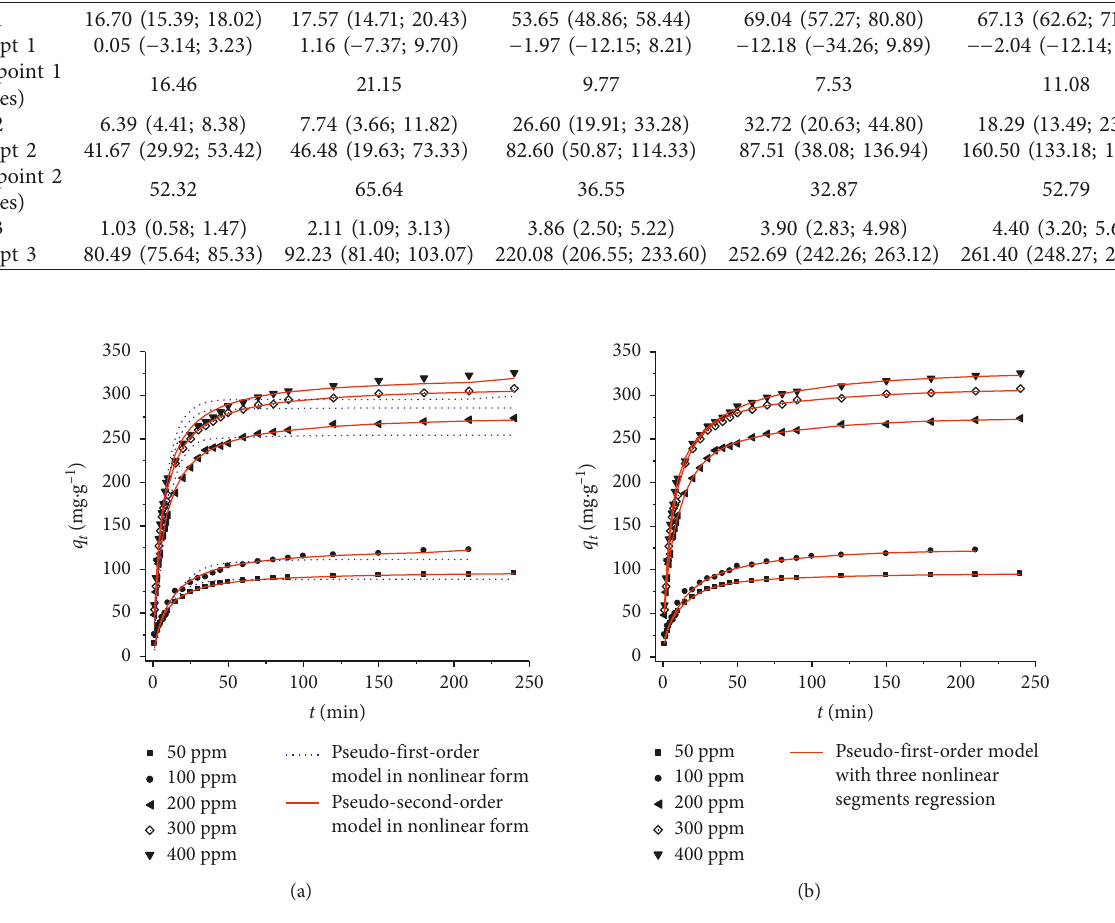
Table 3: Parameters of Weber’s three-linear-segment model (the values in parentheses are 99% confidence intervals). C 0 (ppm)